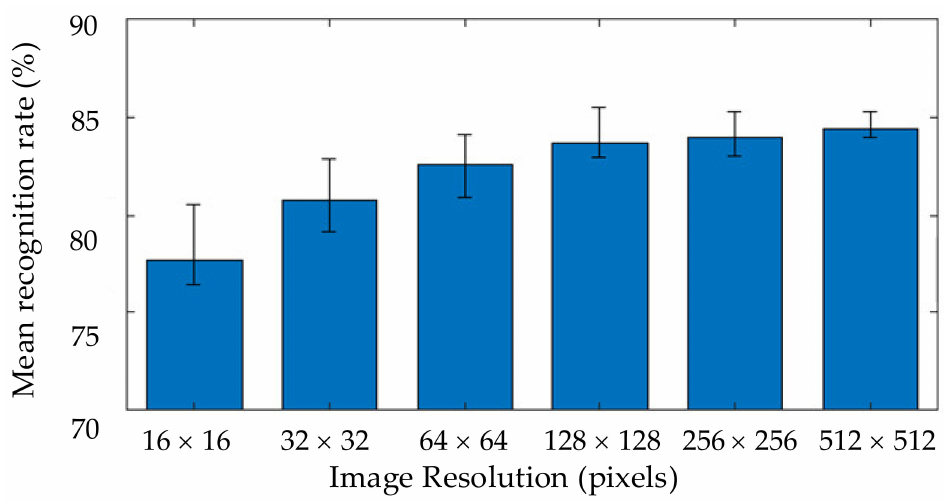
Figure 18. The recognition rate for images obtained with different resolutions.